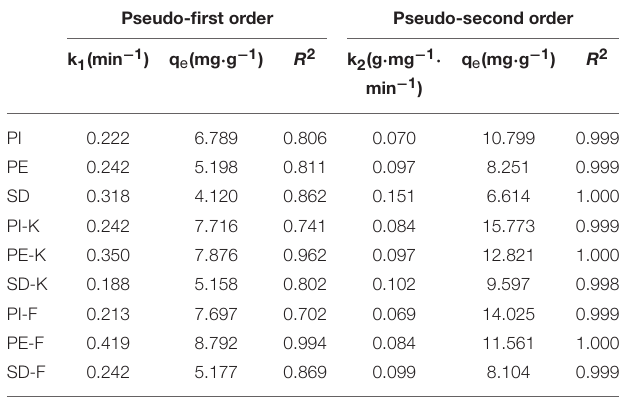
TABLE 3 | Parameters for the pseudo-first and pseudo-second order of Lagergren kinetic models for phenols adsorption on biochars PI, PE, SD and modified biochars PI-K, PE-K, SD-K and PI-F, PE-F, SD-F. Pseudo-first